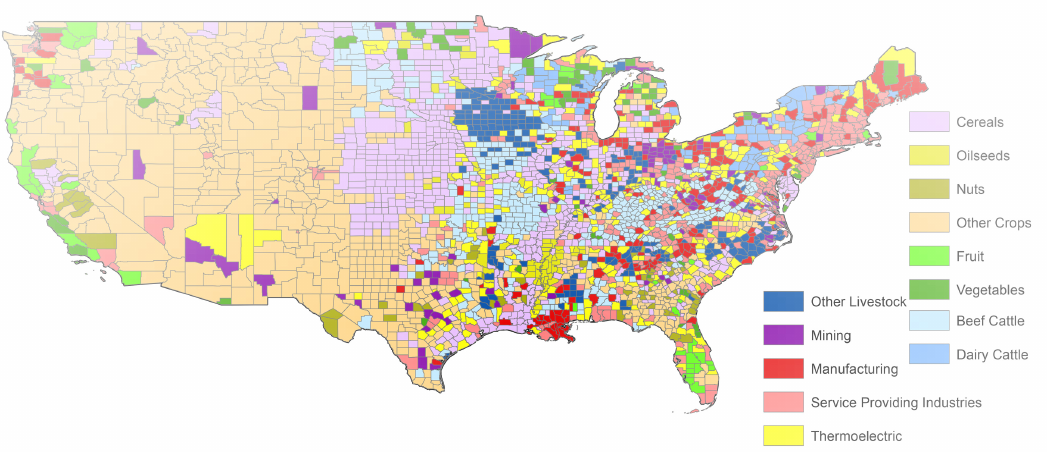
Figure 1. Map of the sector with the largest blue water footprint in each US county. Agriculture is the largest water user in 2164 of the 3143 counties. In other counties, service industries (354), thermoelectric power generation (289), manufacturing (234), and mining (102) are the dominant water users. Note that hydropower, aquaculture, and nonrevenue water uses are not included in the ranking since county-level data are not available for these water uses. This figure is taken from Marston et al. [4] and covers the period